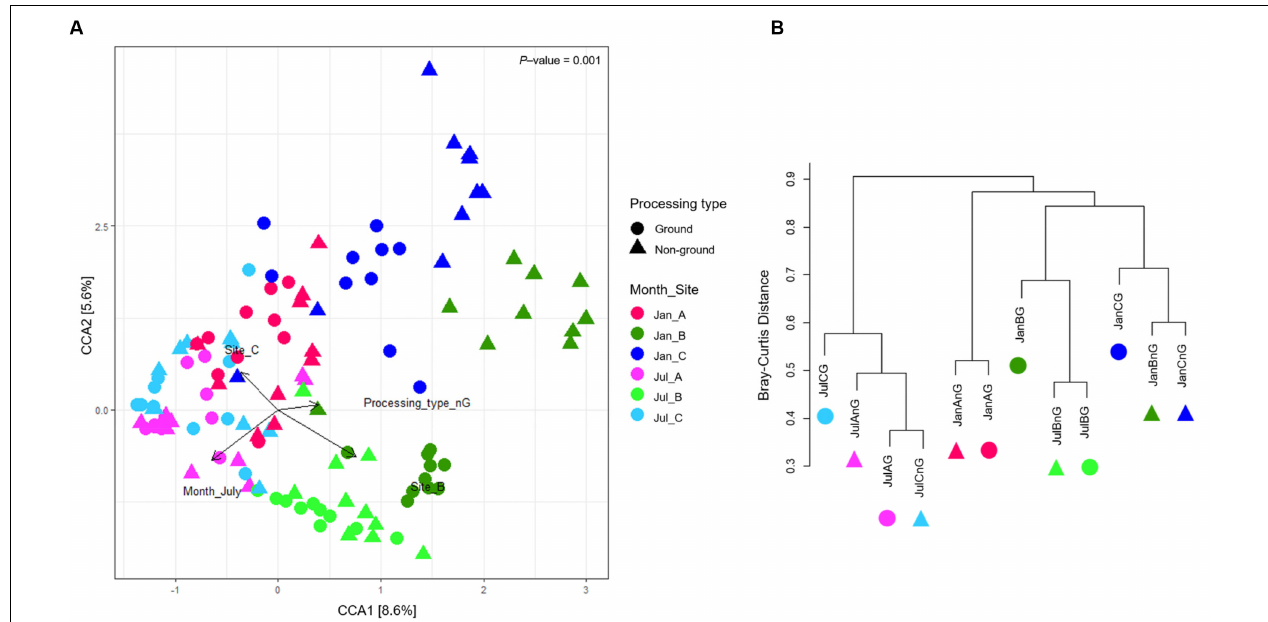
FIGURE 3 | The dissimilarity of microbiota in beef meat samples. (A) Canonical correspondence analysis (CCA) biplot of beef microbiota. The points indicate the microbiota of each sample, and the dissimilarity was calculated by Bray-Curtis distance. The axes represent the percentage of the corresponding total variance. The variables (sampling months, sites, and processing types) were depicted as vectors. The longer vector has stronger effects on the dispersion of microbiota. (B) Clustering of microbiota based on Bray-Curtis distance between samples.